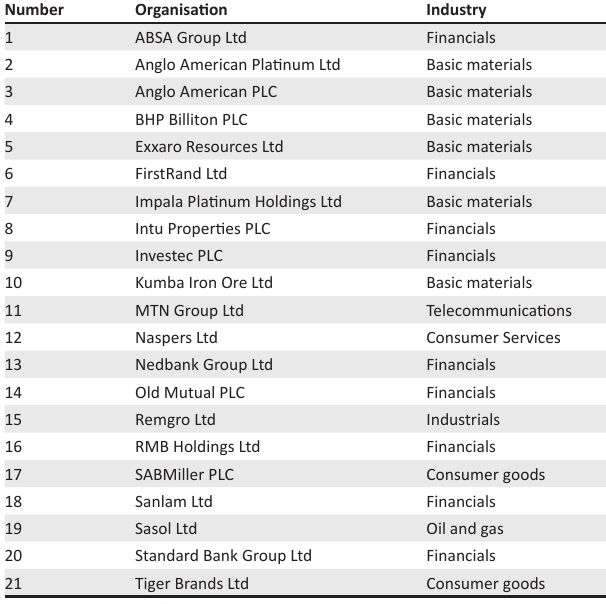
TABLE 1: List of organisations included in the research